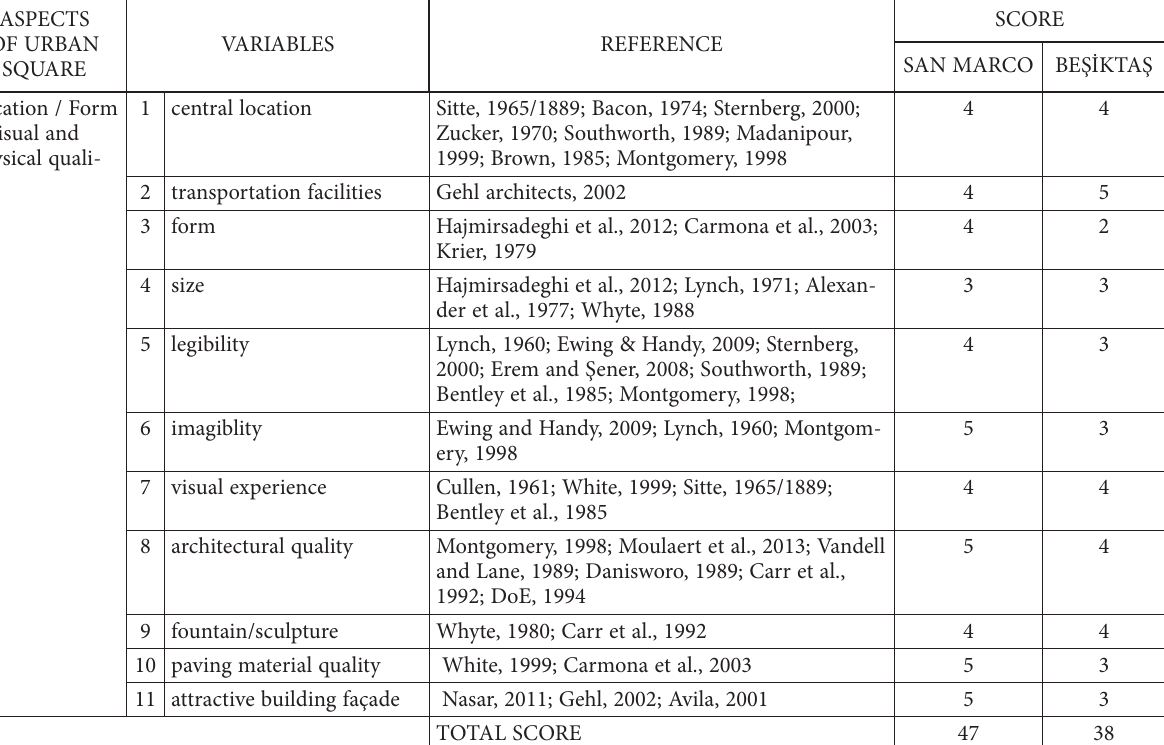
Table 1. Location / Form / Visual and physical quality